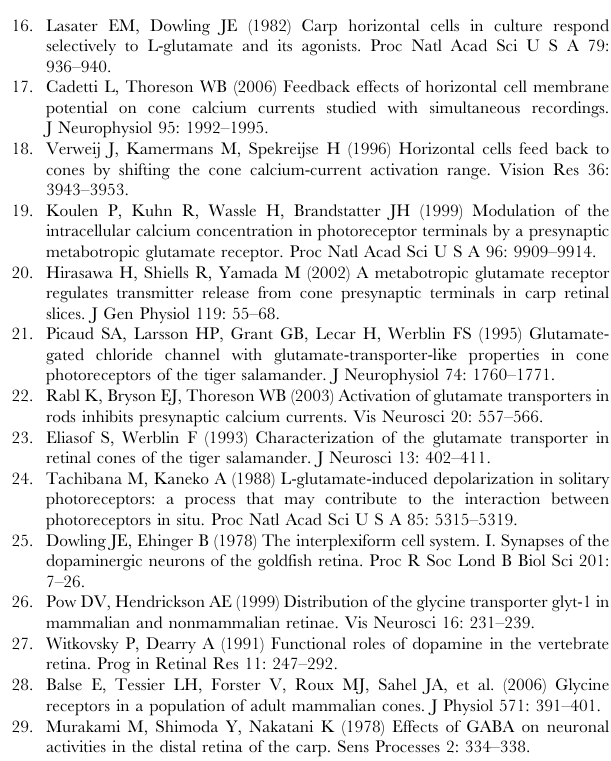
Figure S4 Positive feedback operates through Ca 2 + -permeable AMPA receptors. (A) Bath addition of 100 m M philanthotoxin-74 (PhTx), a blocker of Ca 2 + -permeable AMPA receptors (CP- AMPARs), significantly slows release from cone terminals in darkness ( n = 5, p , 0.05), suggesting that ambient glutamate boosts release by stimulating CP-AMPARs. (B) 20 m M AMPA markedly increases the release rate from cones ( n =16). 100 m M PhTx significantly reduces the effect of AMPA by 68% 6 17% ( n = 5, p , 0.01). Figure S5 Local photolysis of caged glutamate results in local elevation of intracellular Ca 2 + in an HC dendrite. (A) Fluorescent image of an HC in a salamander retinal slice. The cell was filled with the Ca 2 + indicator dye Ca 2 + Orange, and boxes represent regions of interest where fluorescence intensity was measured. MNI-glutamate was uncaged by 2-photon photolysis in the area denoted in Region 2. Scale bar= 10 m m. (B) Difference images showing that uncaging of glutamate elicits an increase in Ca 2 + selectively in Region2, but not in Regions 1 or 3. Images of the three regions were equally contrast enhanced for the purposes of display. (C) Time course of the fluorescent changes in the three regions. Figure S6 Evidence against NO or anandamide as positive feedback transmitters. (A) Drugs affecting the NO